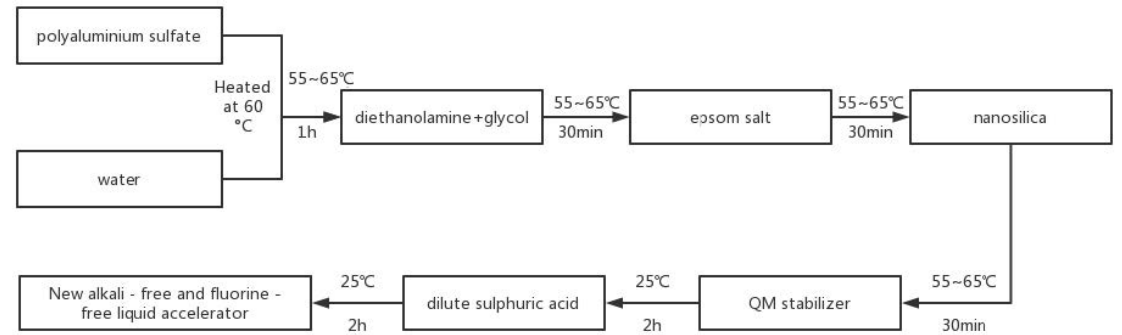
Figure 1. Process of the preparing of new alkali-free and fluorine-free liquid accelerator.